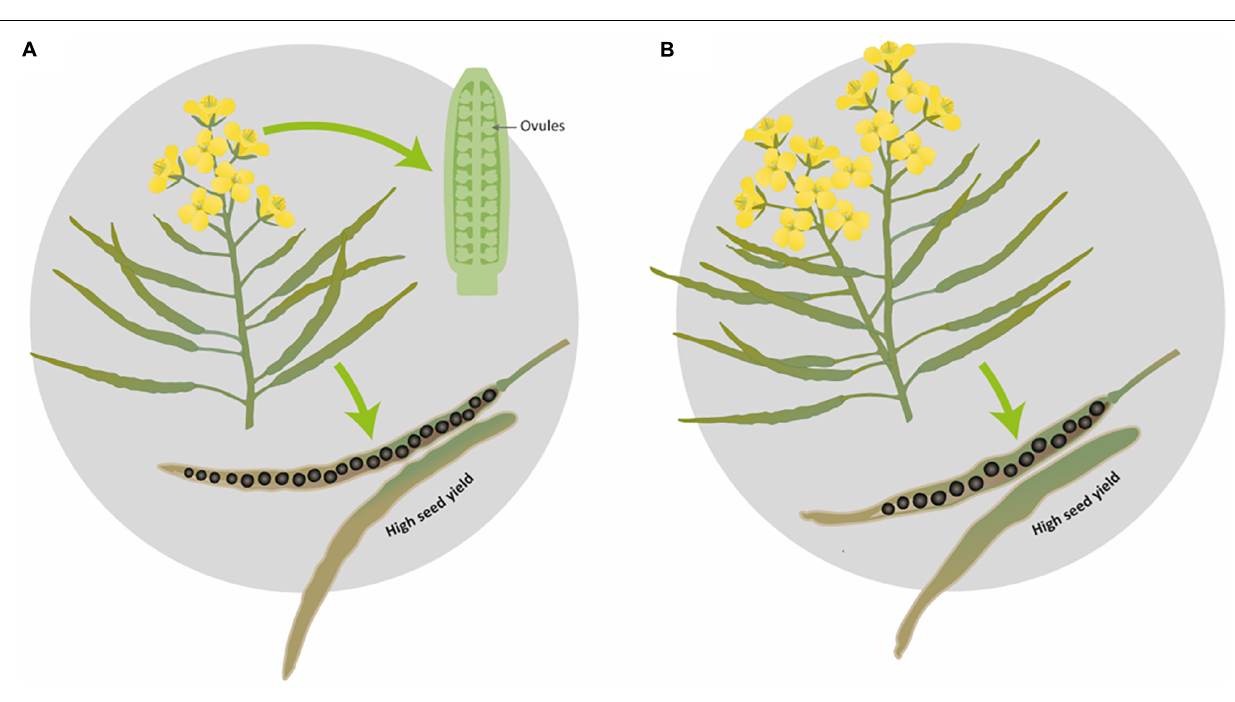
FIGURE 6 | Graphical representation of the proposed ideotypes of Brassica napus for obtaining maximal seed yield. (A) Ideal ideotype for SOSR and WOSR, (B) additional WOSR ideotype leading to high seed